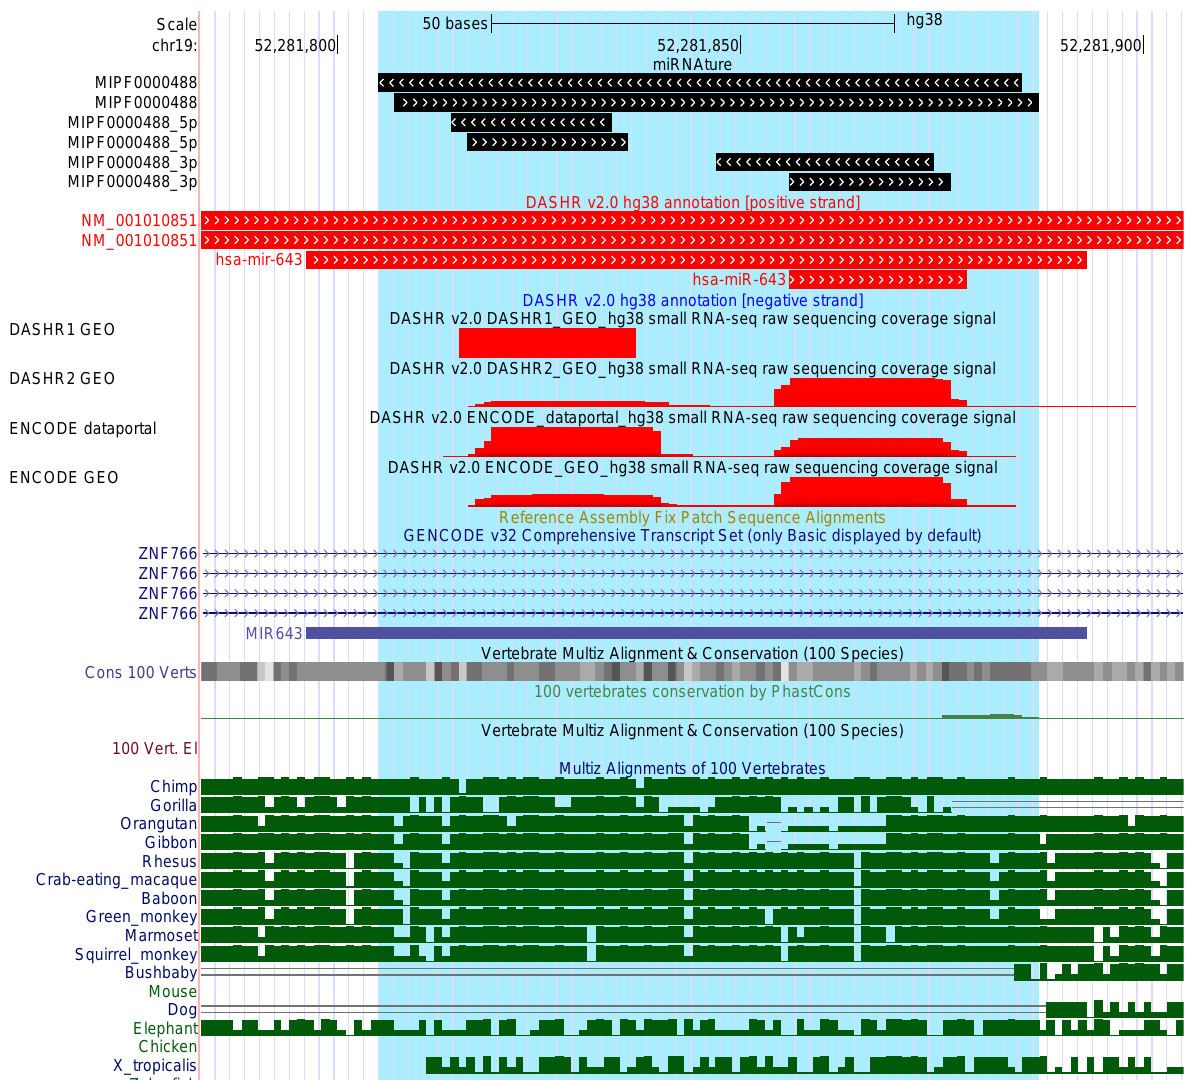
Figure 3. Example of overlappings with current miRNA annotation in human genome. Annotated mir-643 loci were detected by miRNAture on the same strand and additionally an opposite locus from the same family was detected. Supporting expression patterns were detected by both, 5’ and 3’ miR; however, currently only on the 5’ miR is